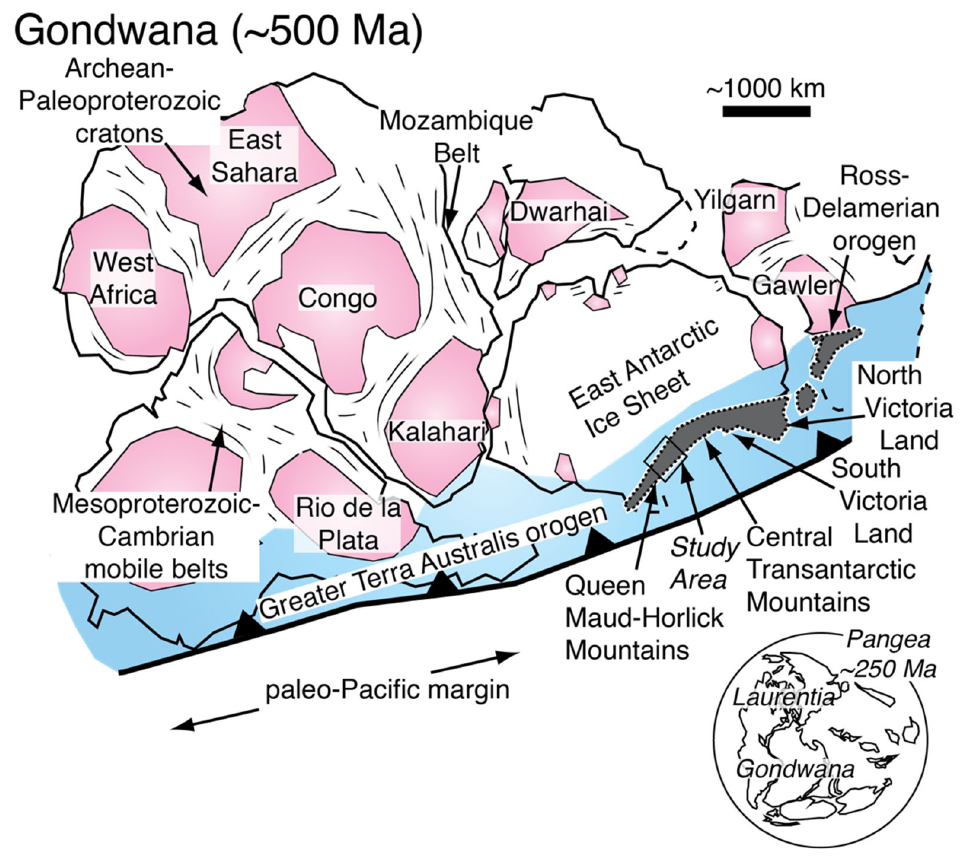
Figure 1. Gondwana reconstruction (~500 Ma) showing the Ross–Delamerian orogen within the greater latest Neoproterozoic to late Paleozoic Terra Australis orogen along the paleo-Pacific margin of Gondwana, as well as the major Precambrian cratons and mobile belts of Gondwana. Inset shows Gondwana within Pangea reconstruction (~250 Ma). Figure modi fi ed from [11,12].